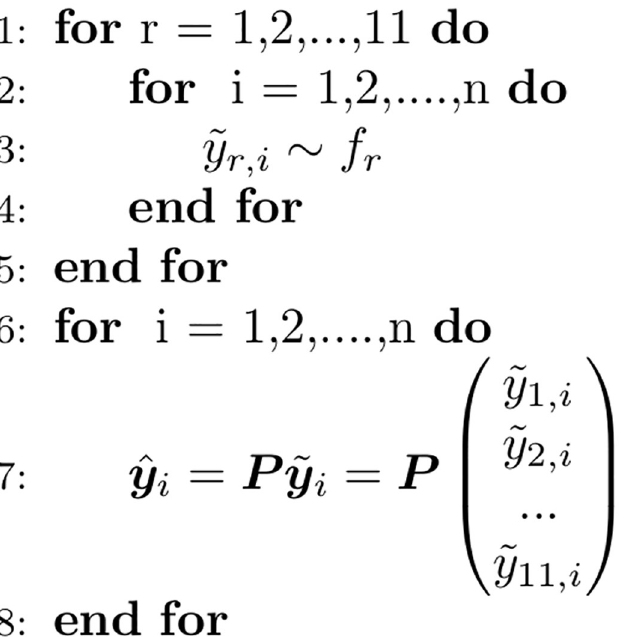
Fig 5. Unordered OLS sampling from probabilistically coherent joint distribution given a collection of marginal distributions. Note that the corresponding weighted ordinary least squares (WOLS) method is obtained by replacing P with P w